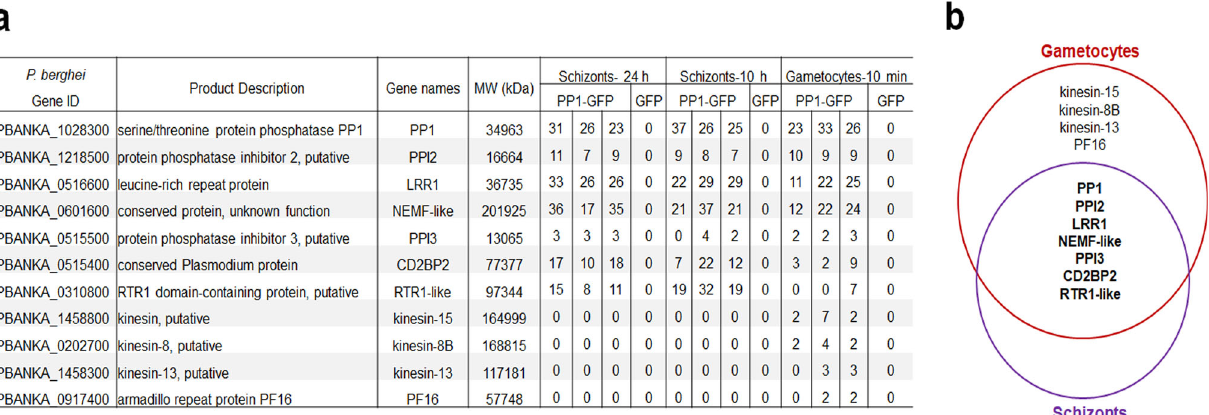
Fig. 7 Interacting partners of PP1 during asexual schizont and sexual gametocyte stages. a List of proteins interacting with PP1 during schizont and gametocyte stages. b Venn diagram showing common interacting partners in schizonts and gametocytes with some additional proteins speci fi c to